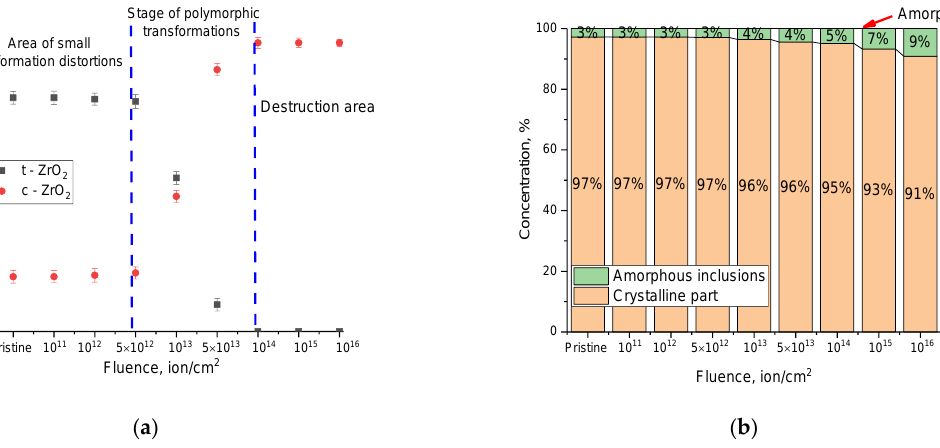
Figure 5. ( a ) Results of the evaluation of the contributions of t-ZrO 2 and c-ZrO 2 in ceramics irradiated with ZrO 2 depending on the irradiation fluence; ( b ) Results of evaluation of the crystallinity degree in ZrO 2 ceramics depending on the irradiation fluence.